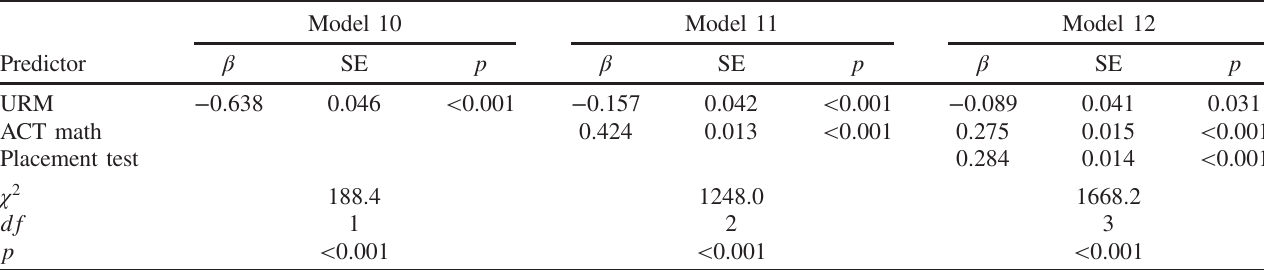
TABLE XI. Binary models predicting physics 1 final exam scores, fall data.